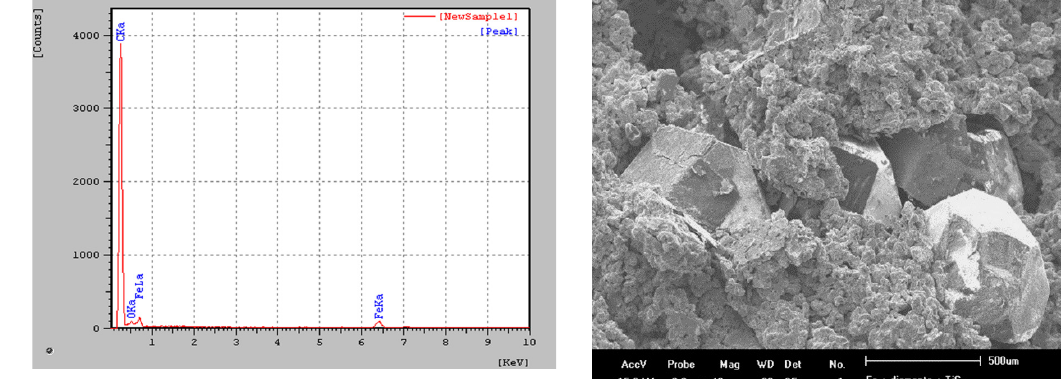
Figure 12. EDS analysis of uncoated diamond in point 02 of Figure 10.